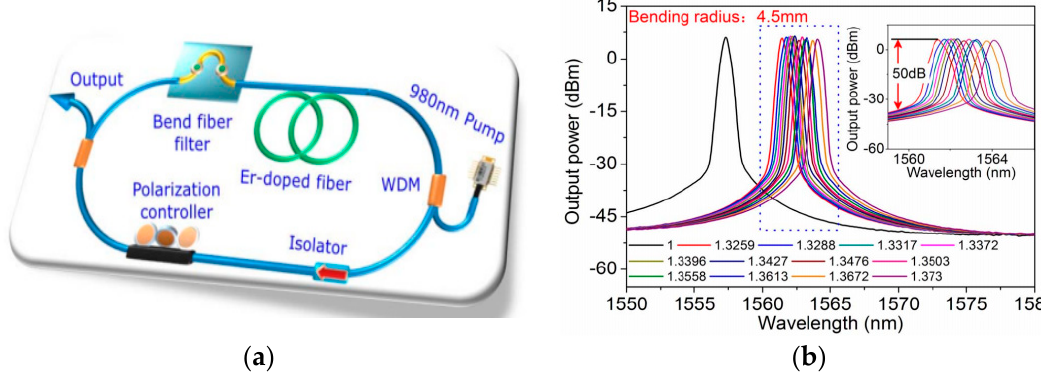
Figure 5. ( a ) Schematic of the proposed FRL; ( b ) Red shift of the fringes as the refractive index (RI)